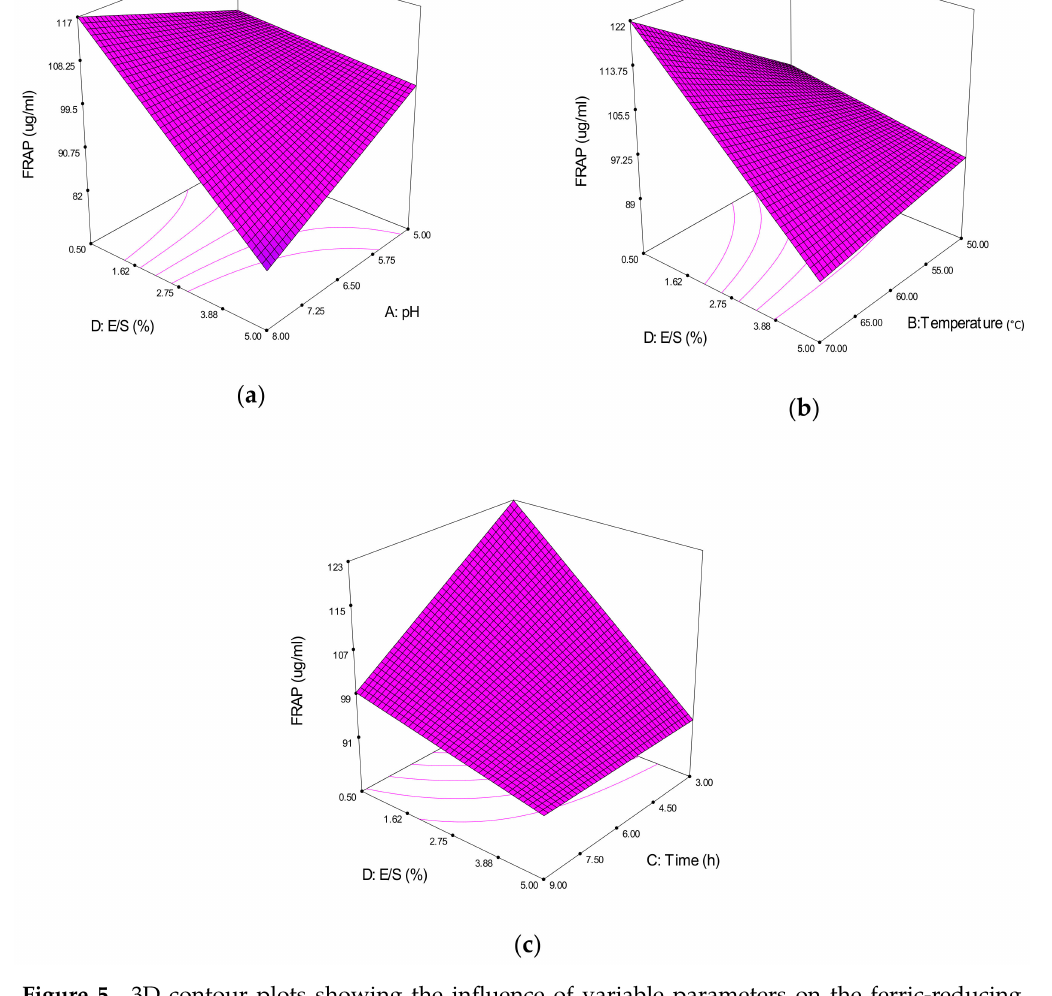
Figure 5. 3D contour plots showing the influence of variable parameters on the ferric-reducing antioxidant power (FRAP) response. ( a ) pH vs. E / S ratio, ( b ) reaction temperature vs. E / S ratio and ( c ) reaction time vs. E / S